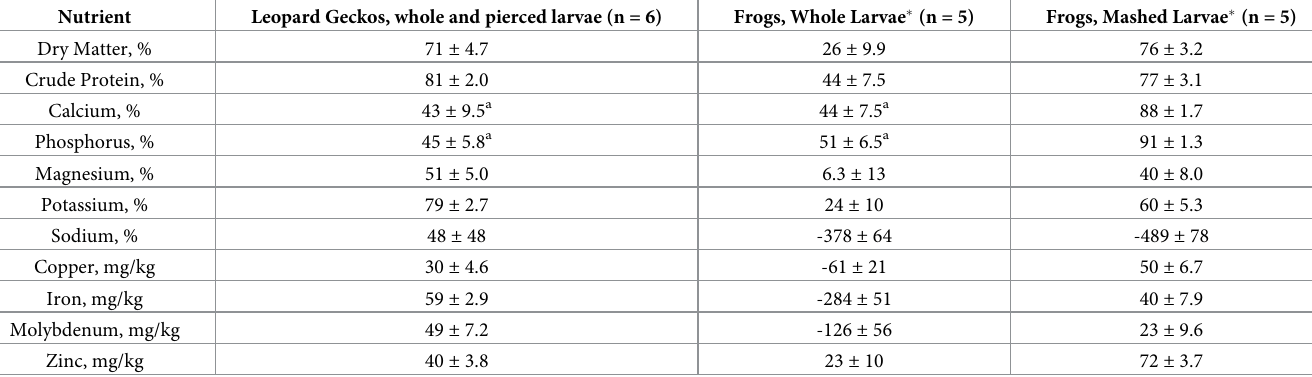
Table 2. Apparent digestibility coefficients for leopard geckos fed a long term (140 days) exclusive diet of BSF larvae compared to published digestibility coeffi- cients for mountain chicken frogs ( Leptodactylus fallux ) fed either whole or mashed BSF larvae for a period of only one day each. Nutrient Leopard Geckos, whole and pierced larvae (n = 6) Frogs, Whole Larvae � (n = 5) Frogs, Mashed Larvae � (n =